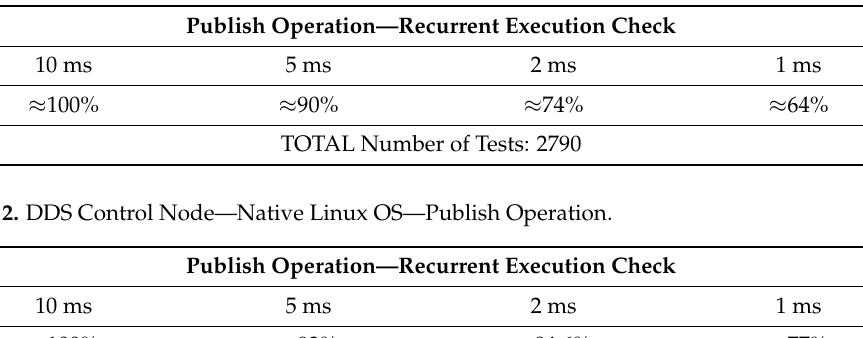
Table 1. DDS Update Node—Virtualized Linux OS—Publish Operation.